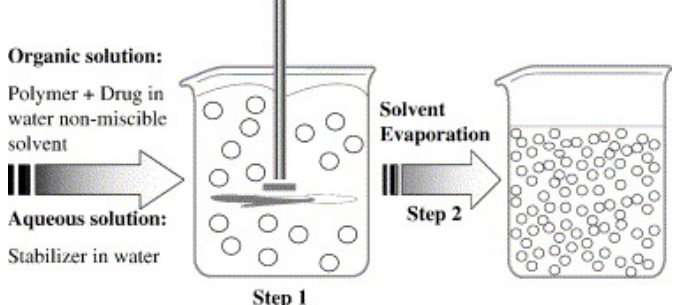
Figure 3. Schematic representation of the solvent-evaporation technique. Reprinted with permission from Reference [53]. Copyright 2006 Elsevier.